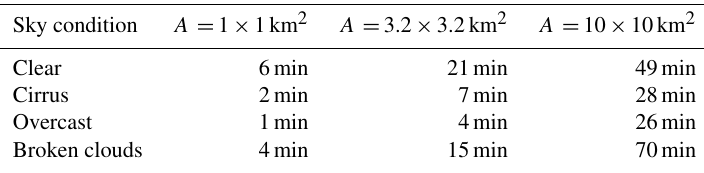
Table 5. The e -folding times (min) for the explained variance between the point measurement and area-averaged values under different sky conditions.